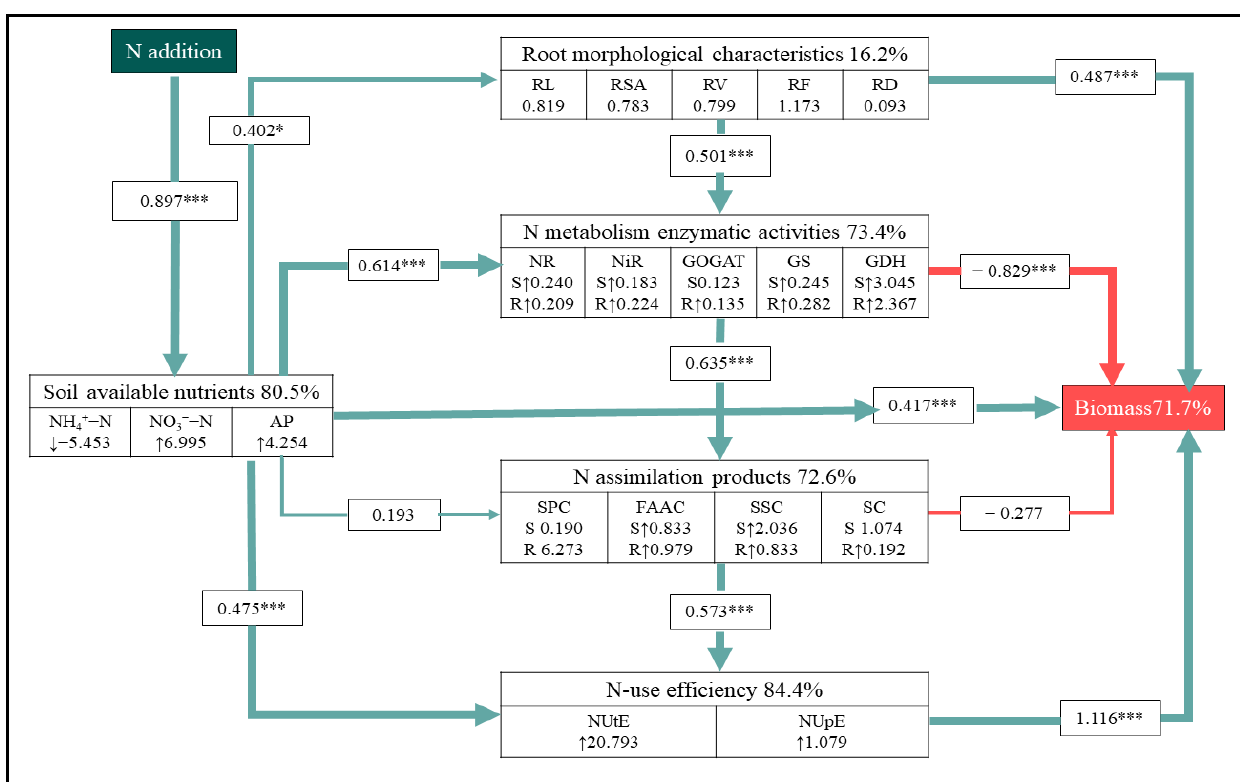
Figure 6. Structural equation model of the effects of N addition on biomass of A. mongolicum . Green solid arrows and red solid arrows indicate positive and negative effects, respectively. The standardized path coefficients are adjacent to the arrows and indicate the size of this effect. The symbols ↑ and ↓ denote a significant increase and decrease ( p < 0.05), respectively, in response to N addition. The letters S and R indicate the responses of shoots and roots to N addition, respectively. The numbers included in variables represent the slope of the linear model of each index with increasing N addition rates as a continuous predictor. The percentages beside the response variables refer to the proportion of variance explained by the model ( R 2 ). * and *** indicate statistically significant at p < 0.05, p < 0.01, and p < 0.001, respectively. Model fit: χ 2 = 2.292, p = 0.994, GFI = 0.969, RMSEA < 0.001. This section may be divided by